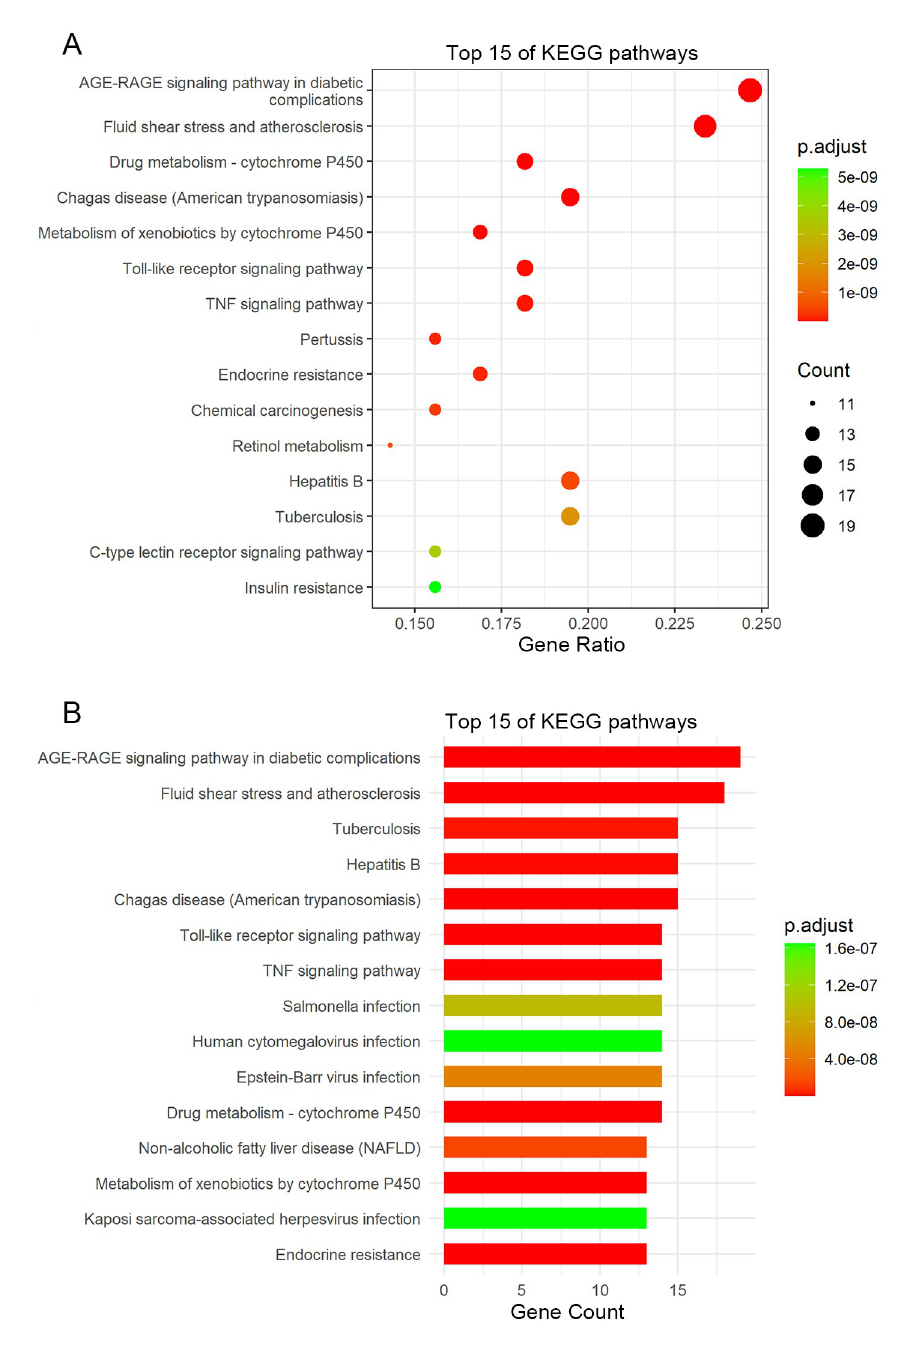
Fig 4. Kyoto Encyclopedia of Genes and Genomes (KEGG) enrichment analysis for 83 potential targets of SHCZF against cholestasis. (A) The bubble chart of top 15 KEGG pathways. (B) The histogram of top 15 KEGG pathways.